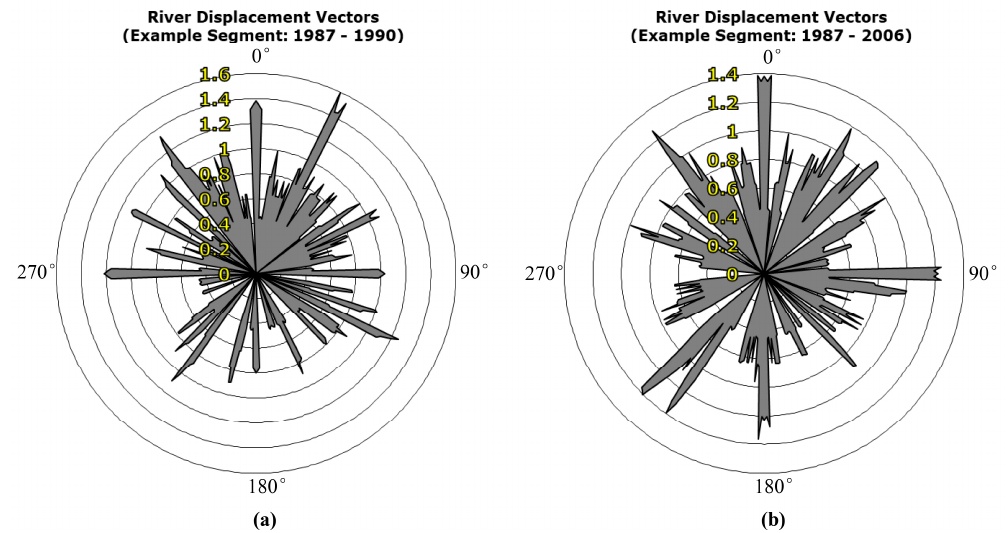
Figure 9. Moving average rose diagrams (MARDs) summarizing the MCC change/displacement vectors for the river class within the example river reach given in Figures 7 and 8, for the periods of ( a ) 1987–1990; and ( b ) 1987–2006. Values on the radar plot axes indicate average weighted frequencies of azimuths.